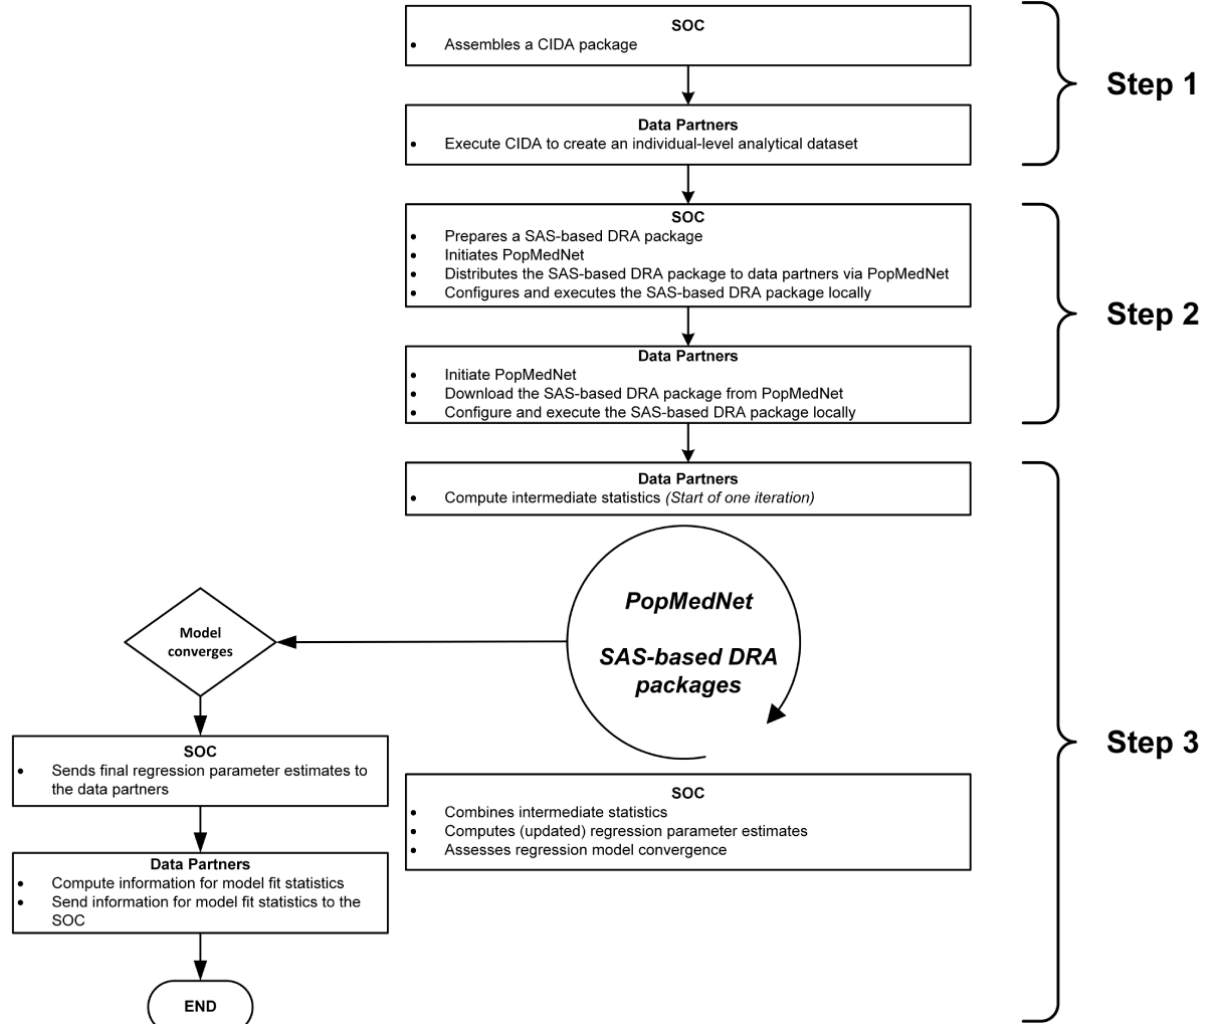
Figure 2. Three-step process to conduct distributed regression analysis with PopMedNet. CIDA: Cohort Identification and Descriptive Analysis Tool; DRA: Distributed Regression Analysis; SOC: Sentinel Operations